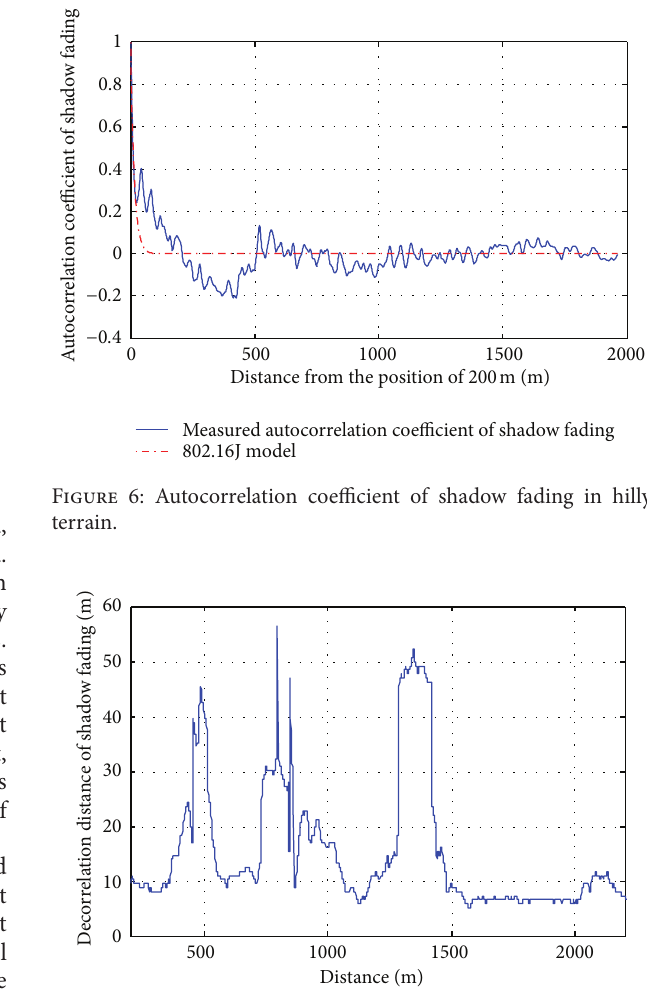
Figure 7: Decorrelation distance of shadow fading in hilly